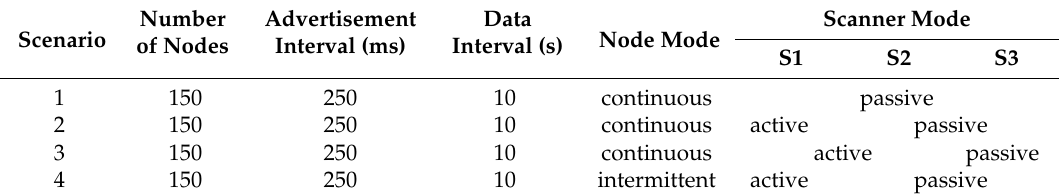
Table 3. Settings for the real-life experiment